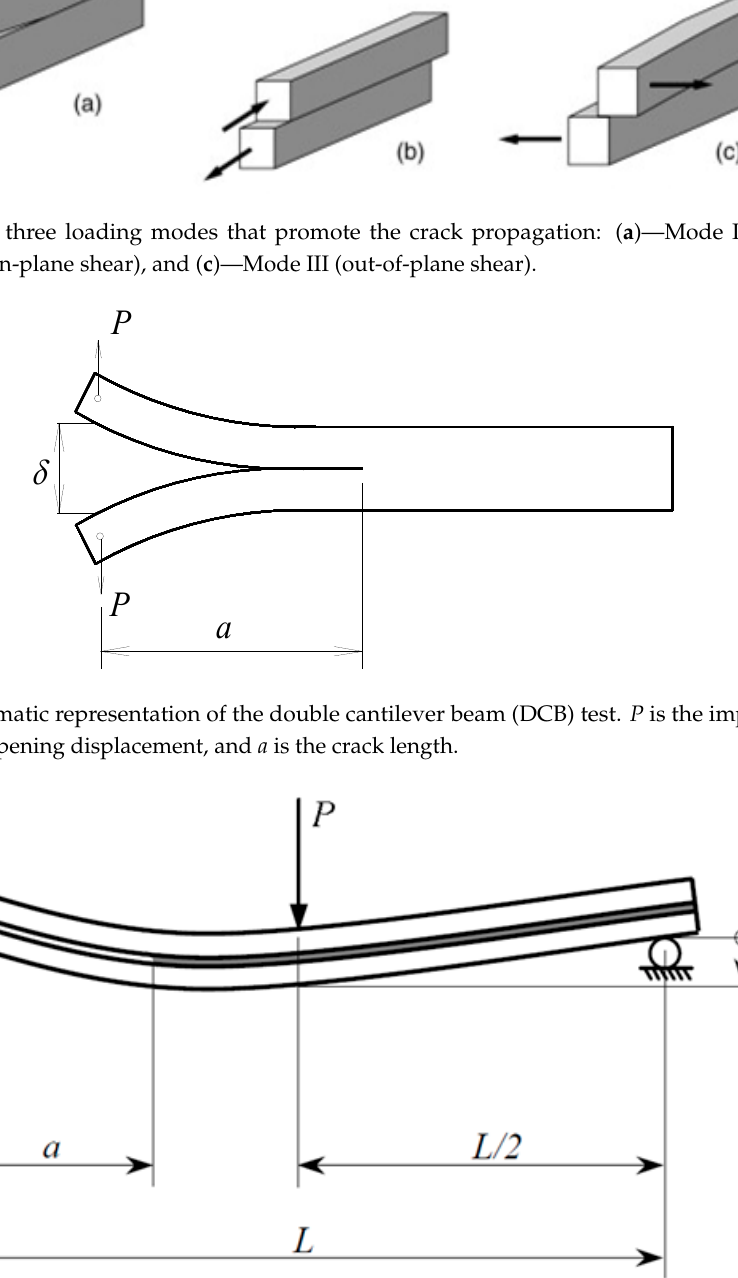
Figure 5. Schematic representation of the End Notched Flexure (ENF) test. P is the imposed load, δ is the specimen’s deflection, L is the length of the specimen, and a is the crack